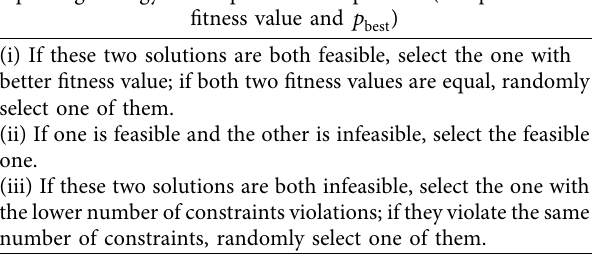
Table 1: The commonly used updating strategy for p . best Updating strategy for the personal best position (compare current fitness value and p best